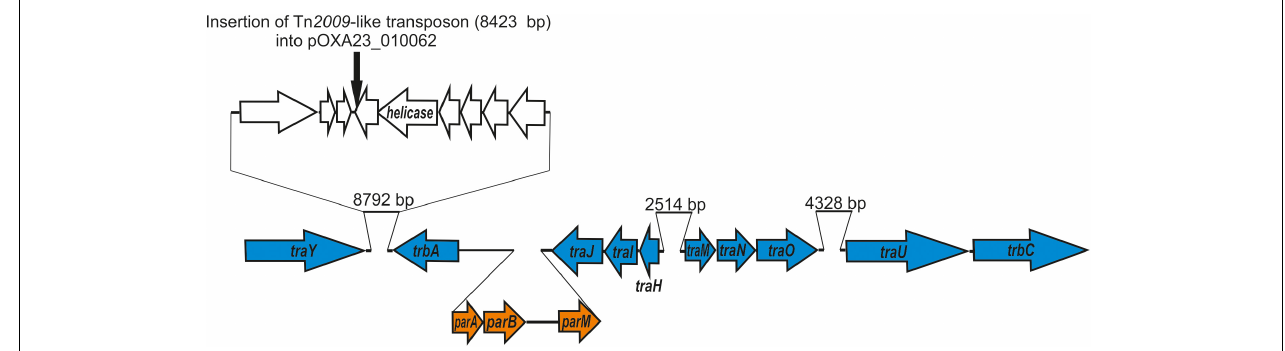
FIGURE 1 | Genetic structure of pALWED1.1 region involved in conjugation. The location and polarity of genes are shown with arrows. Genes of MPF complex are marked in blue; genes encoding partitioning process—in orange. In the top the site of insertion of Tn 2009 (black arrow) into the plasmid pOXA23_010062 is